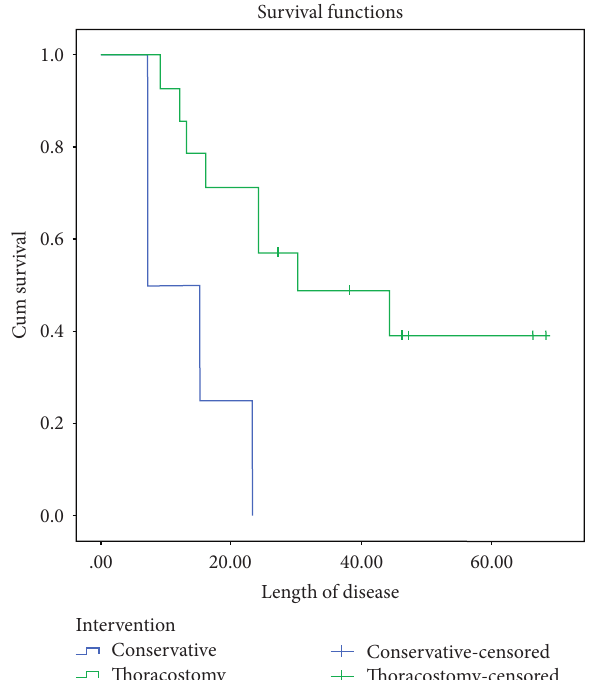
Figure 3: The survival curve of our patients between who underwent conservative treatment and thoracostomy tube